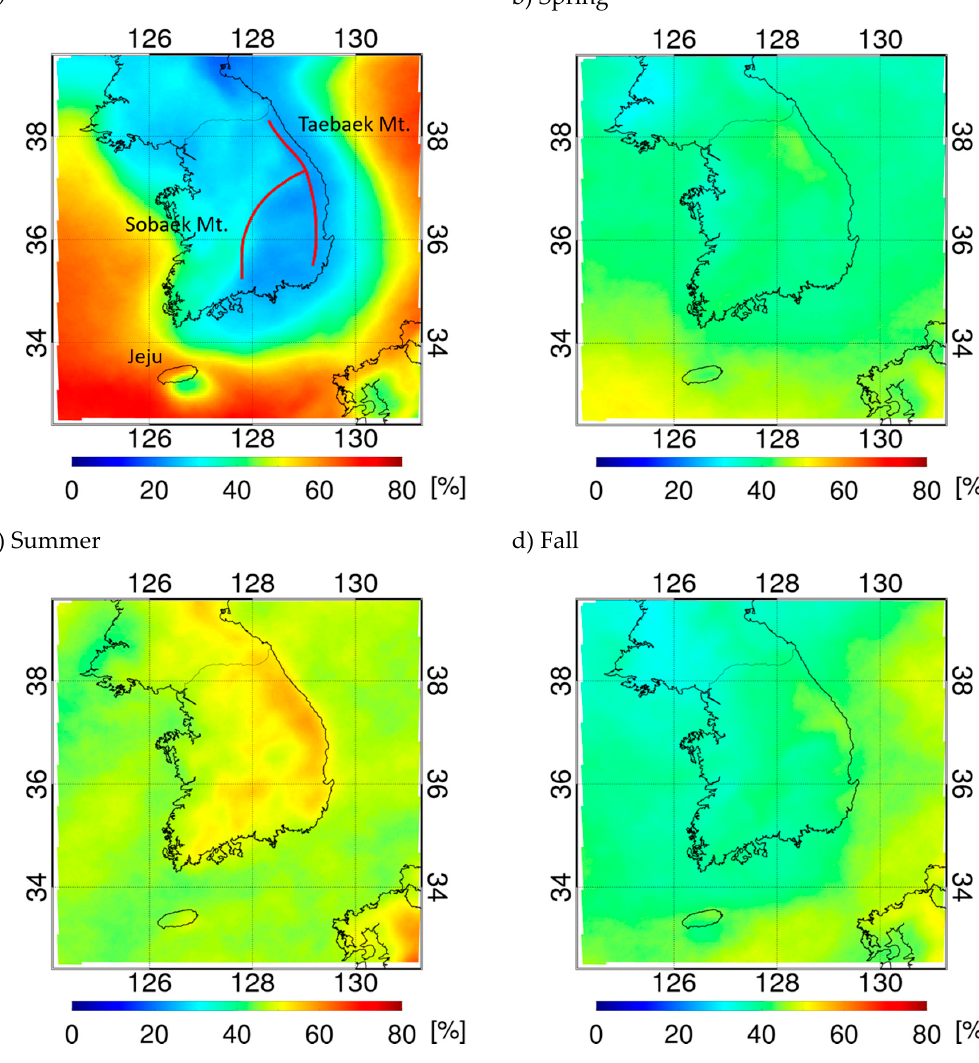
Figure 2. Frequency distribution by season ( a – d ) of clouds with COMS cloud fraction exceeding 80% (the solid red line indicates the Taebaek and Sobaek Mountains).